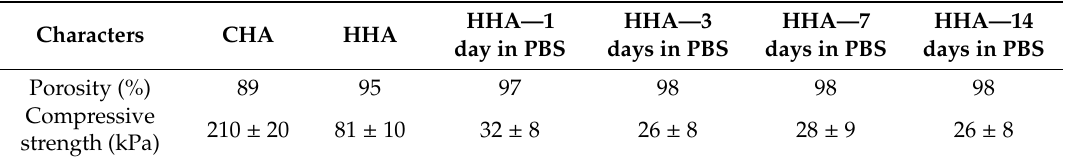
Table 1. Compressive strengths of the CHA and HHA scaffolds as-synthesized, and for HHA after degradation in PBS for 1–14 days.